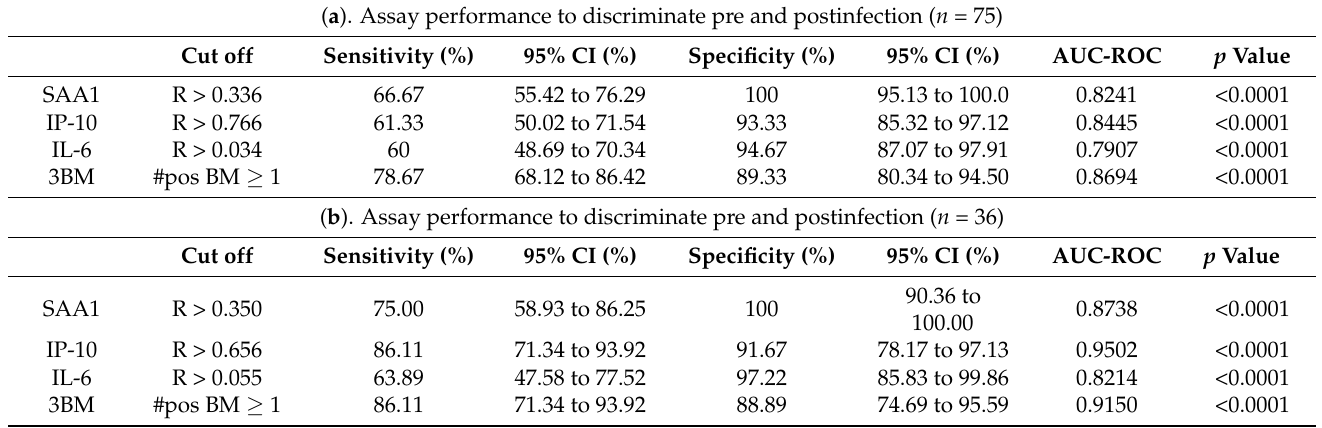
Table 1. Assay performance characteristics of UCP-LFAs in MTB infected rhesus